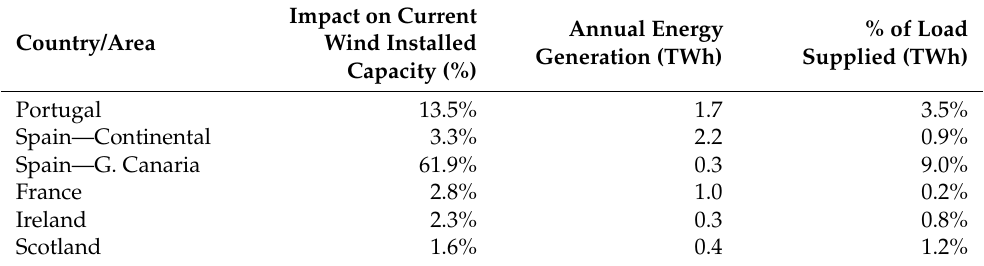
Table 7. Impact on energy mix.